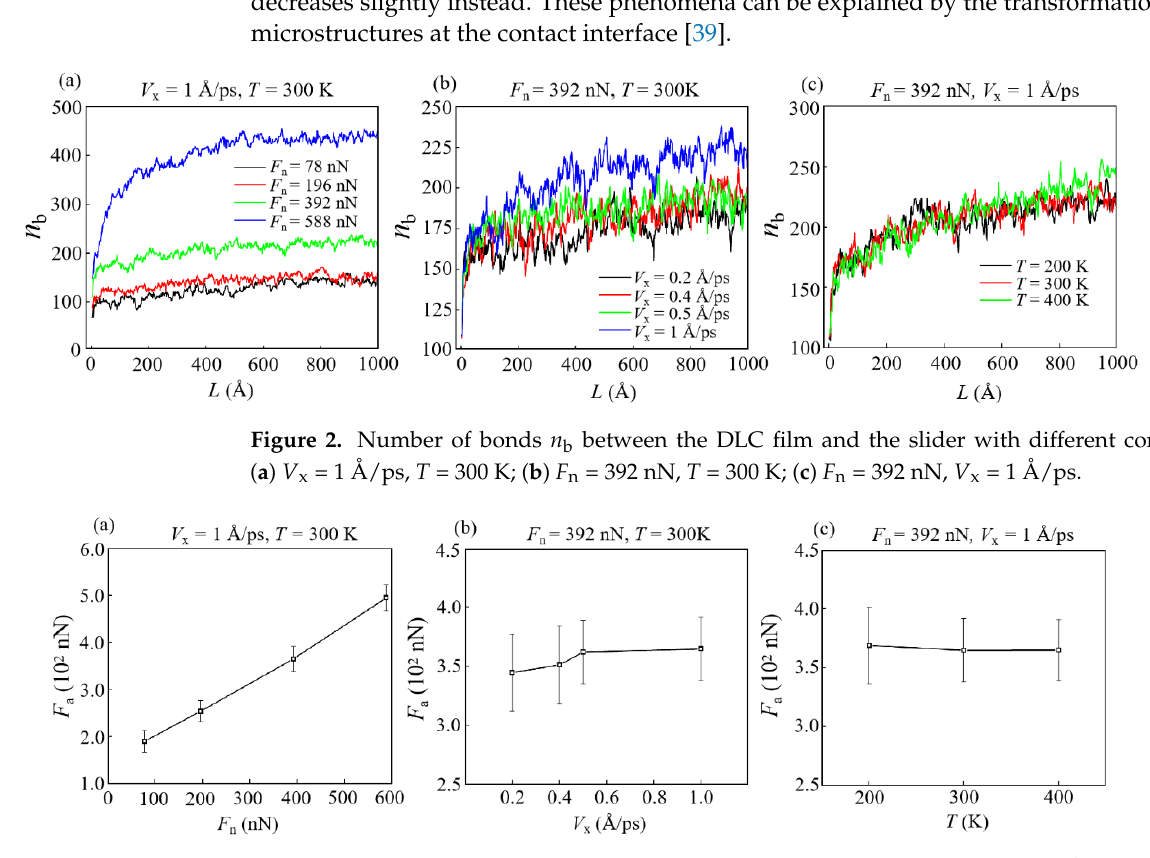
Figure 2. Number of bonds n b between the DLC film and the slider with different conditions : ( a ) V x = 1 Å /ps, T = 300 K; ( b ) F n = 392 nN, T = 300 K; ( c ) F n = 392 nN, V x = 1 Å /ps.